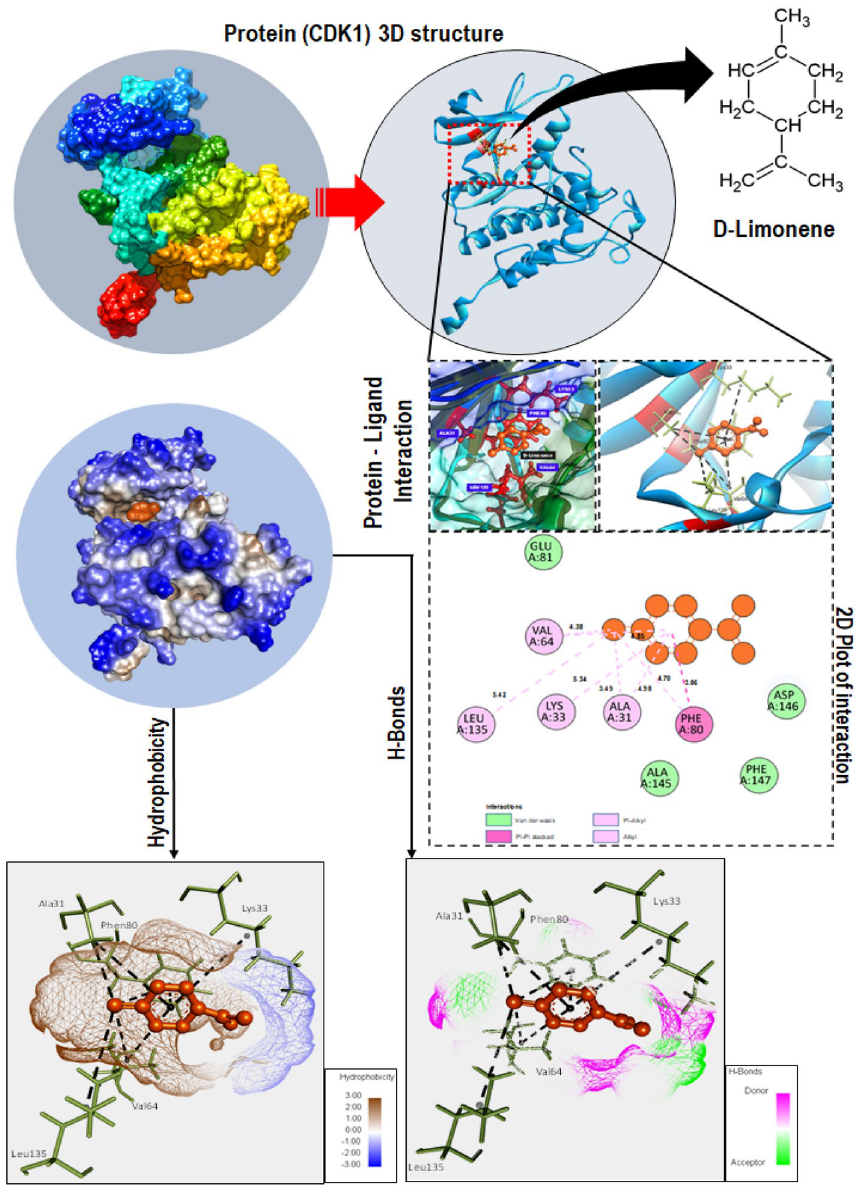
Figure 6. Molecular interaction of CDK1 protein (Homo sapiens) residues with d-limonene as predicted through molecular docking. The docking was performed using Autodock Vina. CDK1: Cyclin-dependent kinase 1; H-bond: Hydrogen bond. CDK1 was found to interact with d-limonene via different amino acids like valine (VAL64), leucine (LEU135), lysine (LYS33), phenylalanine (PHE80) and alanine (ALA31) through hydrogen bond and Vander wall forces through different level of binding